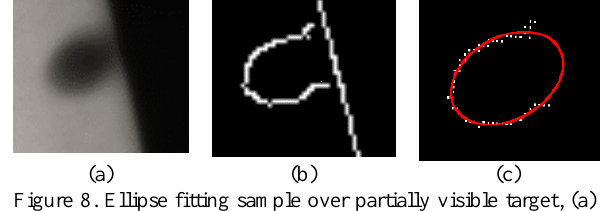
Figure 8. Ellipse fitting sample over partially visible target, (a) source image, (b) target edge pixels and (c) the fitted